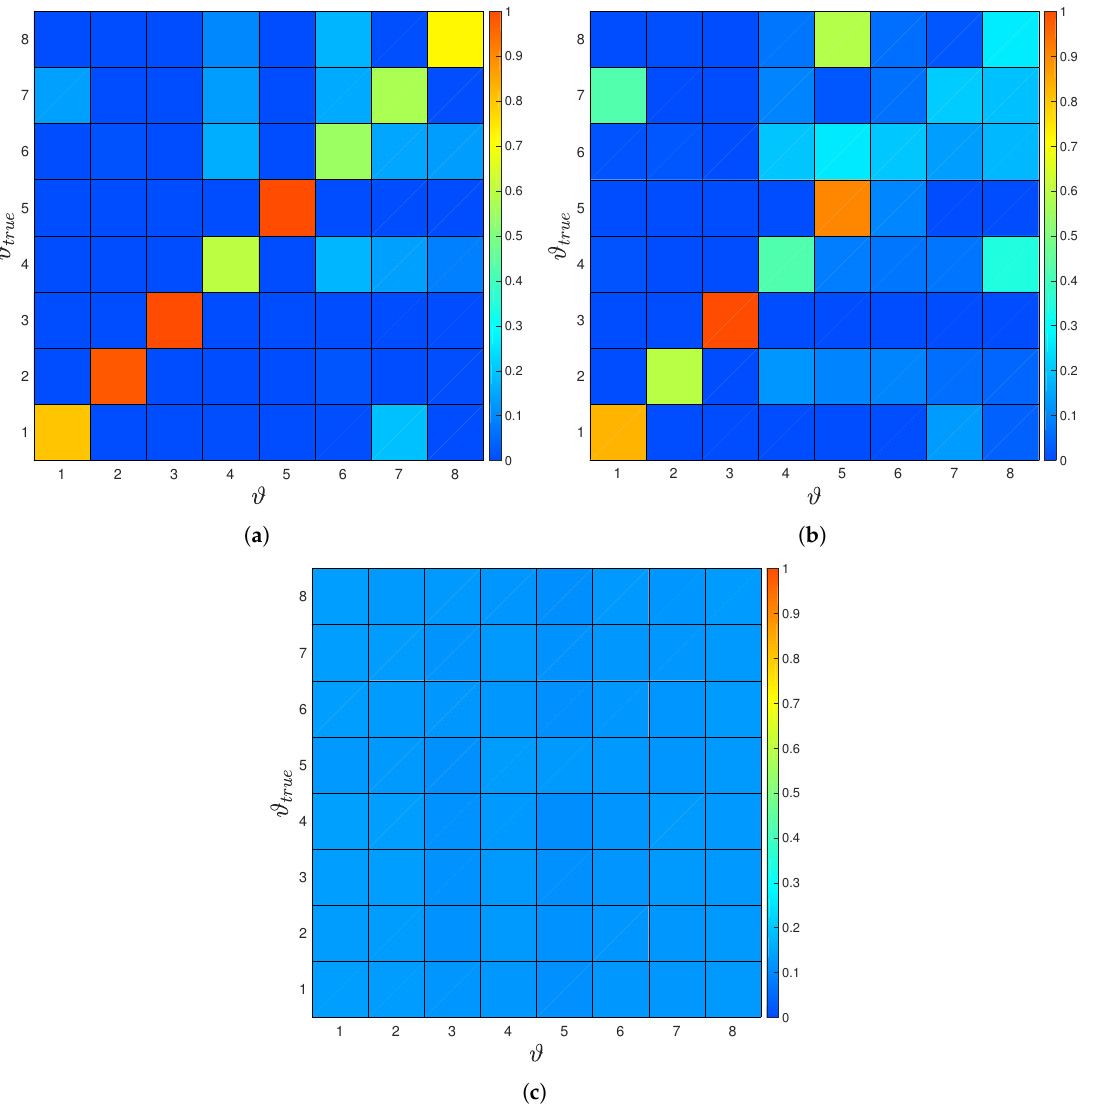
Figure 7. ( a ) Estimated posterior probability for a single sensor optimally placed and a single configuration per group size. The posterior shows clear peaks at the correct number of swimmer for all cases, leading to perfect inference of the parameter of interest. The posterior probability for ( b ) optimal and ( c ) worst sensor location for multiple configurations per group size. Here, for the optimal sensor location and one, two, three and five swimmer we see a clear peak for the true size of the group. For the worst sensor location the posterior is almost uniform and does not allow to extract any information about the size of